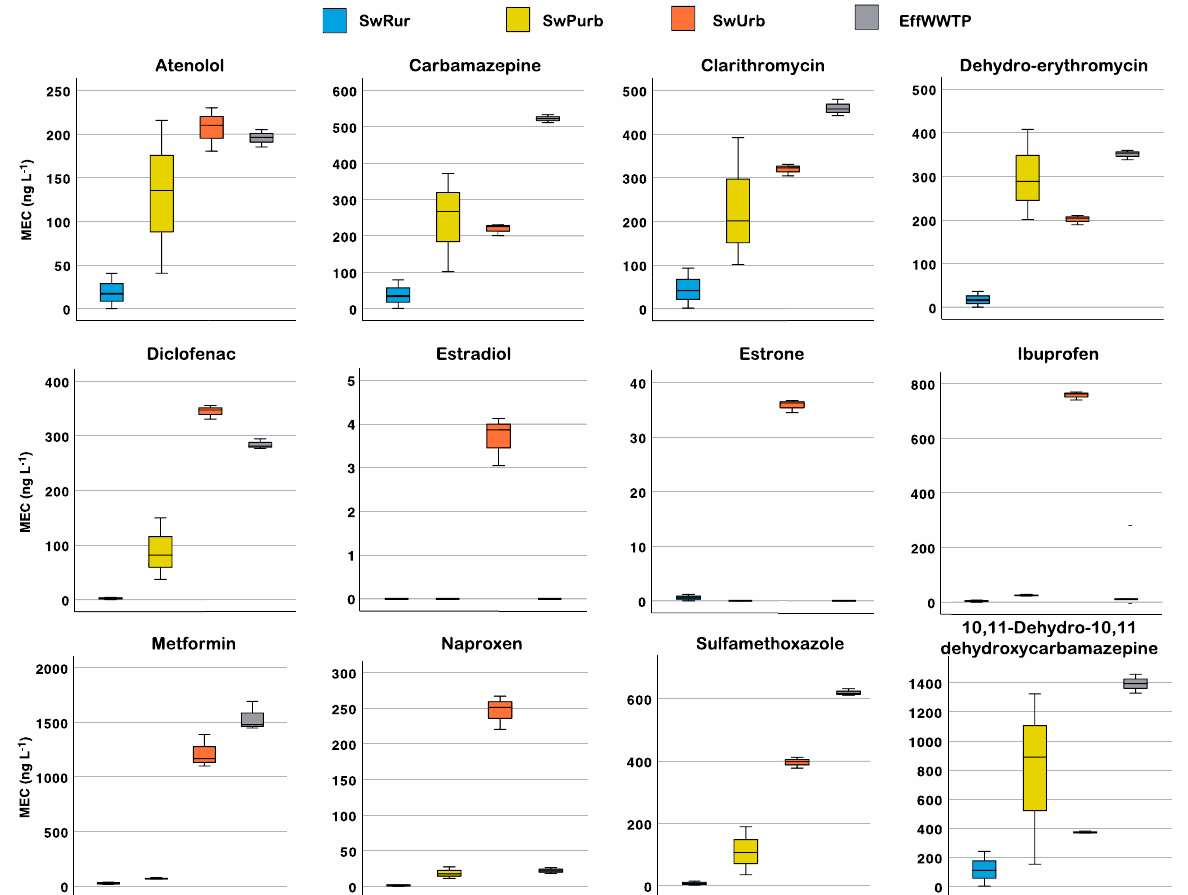
Figure 2. Box plot indicating measured environmental concentration (MEC) of selected pharmaceuticals (ng L − 1 ) in surface waters and effluent wastewater collected in March 2016 from the sampling points in a coastal area of Central Italy (SwRur: rural area; SwPurb: periurban area; SwUrb: urban area; EffWWTP: effluent of the wastewater treatment plant). The box indicates the 25th and 75th percentiles, the horizontal line indicates the median, and the whiskers indicate the lowest and the highest values. Dehydro-erythromycin and 10,11-dehydro-10,11-dehydroxycarbamazepine are metabolites of erythromycin and carbamazepine, respectively.